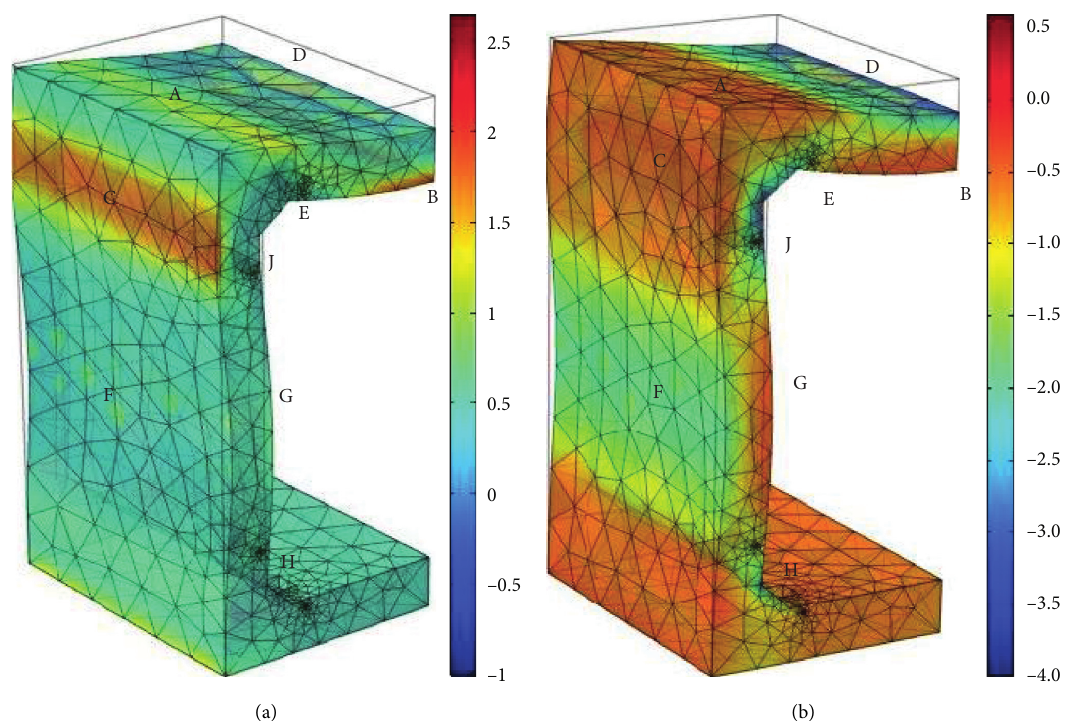
Figure 7: Principal stress cloud of the model. (a) First principal stress. (b) Third principal